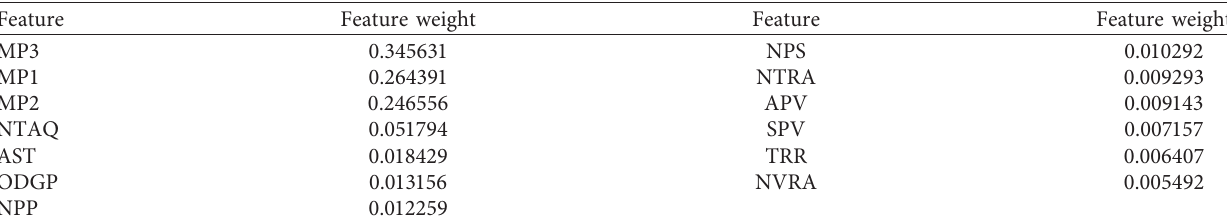
Figure 16: Performance comparison of the experimental and control groups after the early intervention experiment. Table 5: Independent feature weights in predicting the final